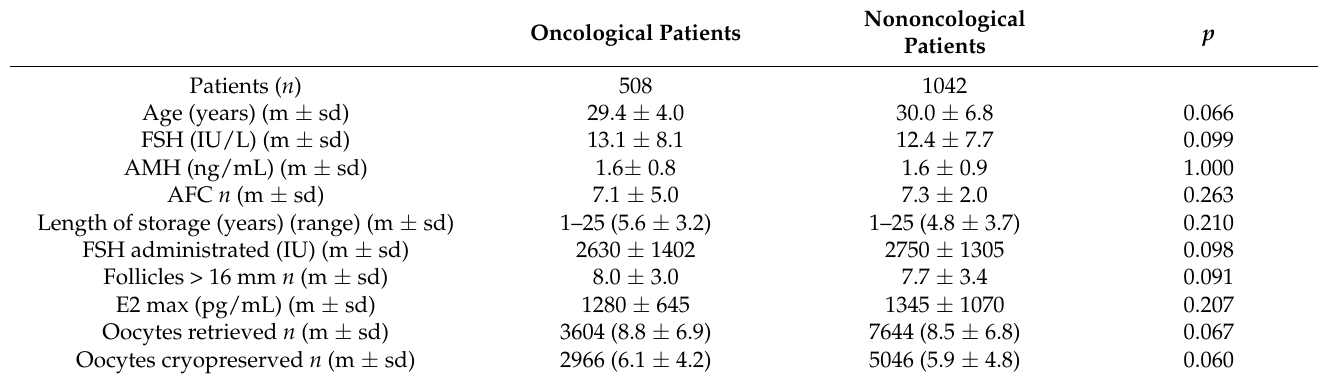
Table 2. Patients’ basal characteristic and oocyte features in oncological patients vs. nononcological patients.